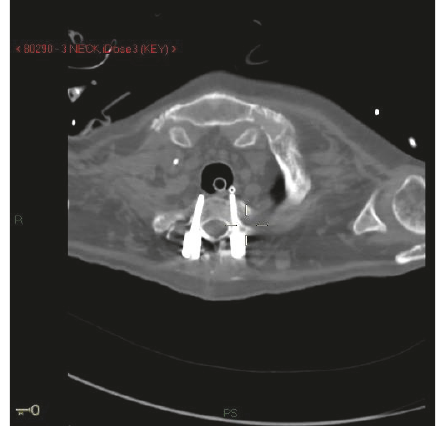
Figure 1: Computed tomography (axial view): fixation screw abet- ting the